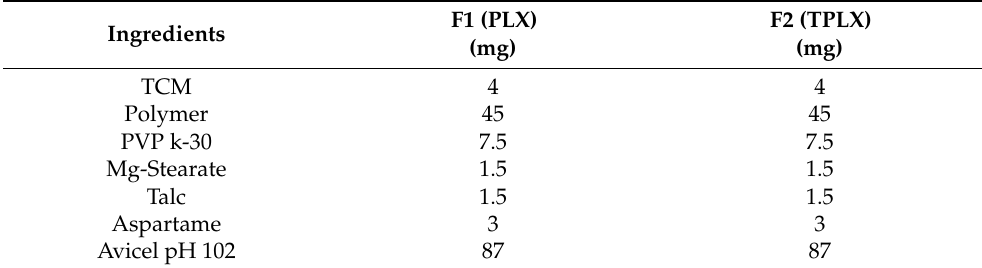
Table 1. Composition of modified-release tablets of